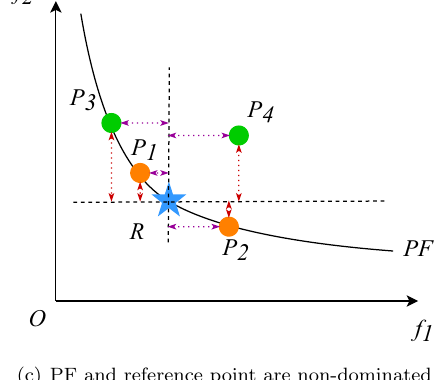
Fig. 1 The domination relation in different